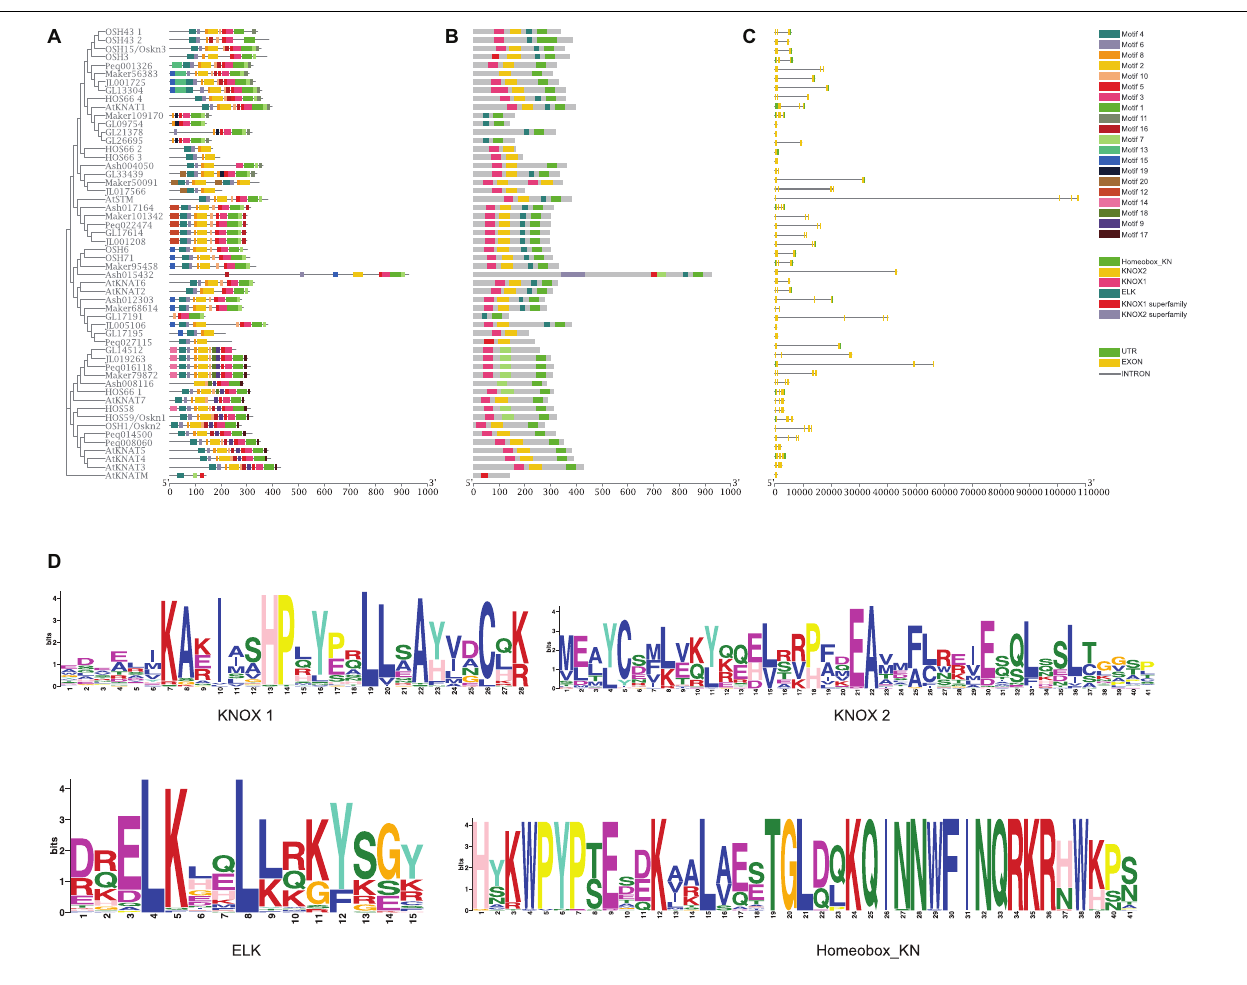
FIGURE 3 | Gene structure, conserved motifs, conserved domains of KNOX genes. (A) Predicted motifs with the phylogenetic tree of orchid KNOXs. (B) Conserved KNOX domains. (C) Gene structure of KNOXs, with green blocks, yellow blocks, and gray lines representing upstream or downstream-untranslated regions (UTR), exons, and introns, respectively. (D) Sequence logo of Motif 4, motif 2, motif 5, and motif 1, which encoded the KNOX1, KNOX2, ELK, and Homeobox domains,